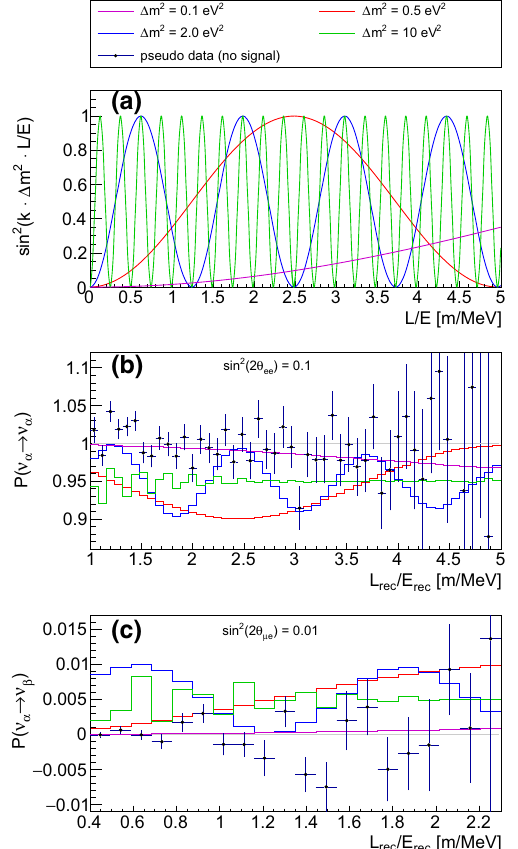
Fig. 1 a Normalized probability of a neutrino flavor oscillation as a function of L / E for different Δ m 2 values. The absolute probability is given by the product between the plotted normalized probability and sin 2 ( 2 θ) . b , c Probability of neutrino oscillations as a function of L rec / E rec for two toy experiments searching for a disappearance ( b ) and an appearance ( c ) signal. The probabilities are shown assuming the existence of sterile neutrinos at various possible sin 2 ( 2 θ) and Δ m 2 values. The reconstructed probability from pseudo-data generated with Monte Carlo simulations under the hypothesis that there are no sterile neutrinos are also shown. The experimental parameters of the two toy experiments are summarized in Table 1. The binning reflects the typical experimental resolutions on L rec and E rec . The error bars account for the statistical uncertainties before background